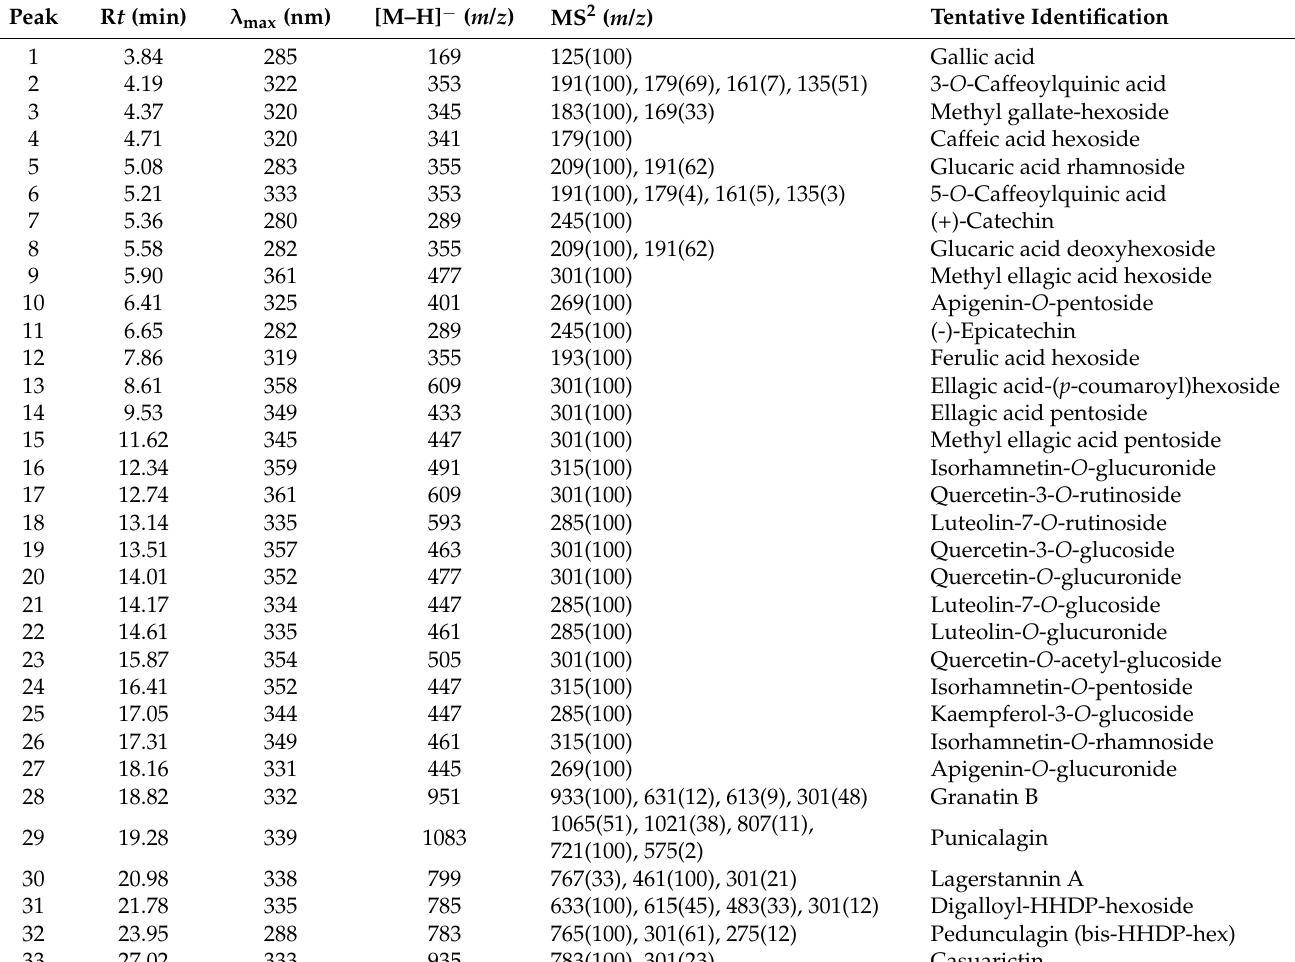
Table 1. Retention time (Rt), the wavelength of maximum absorption ( λ max ), mass spectral data, and tentative identification of the phenolic compounds present in the three leaf